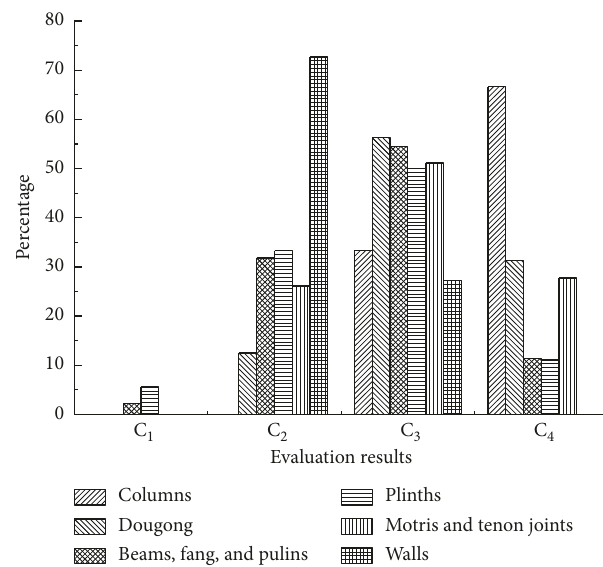
Figure 7: Evaluation results for components.